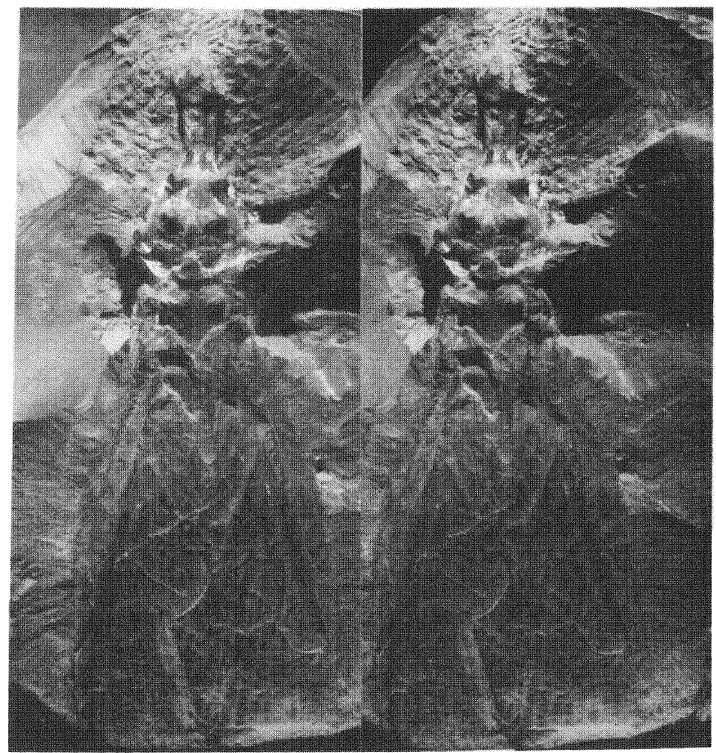
Fig. 11. Gerarus danieisi, stereophotograph of FMNH PE 5276, reverse half. Total length 77 mm. Photograph by F. M.